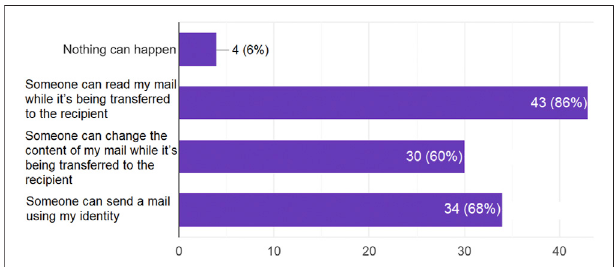
FIGURE 4 | Answers to the question: Considering a scenario of using non-encrypted e-mail communication, which of the following may